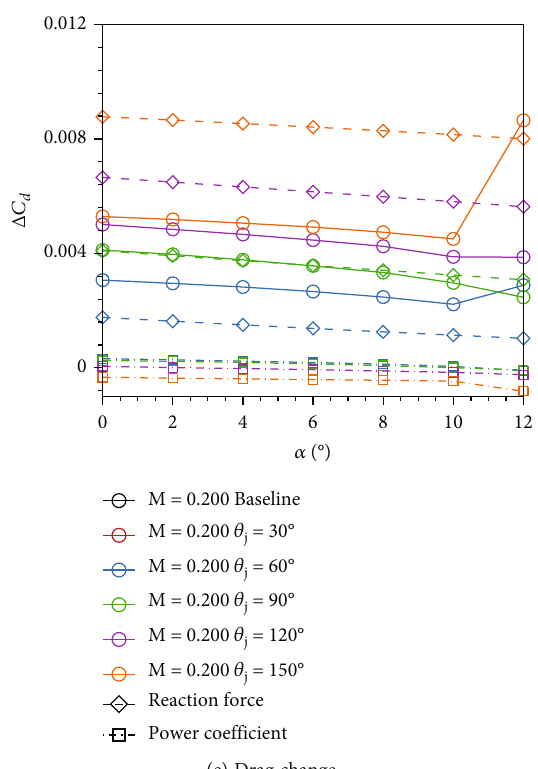
Figure 8: Subsonic aerodynamic performances at M